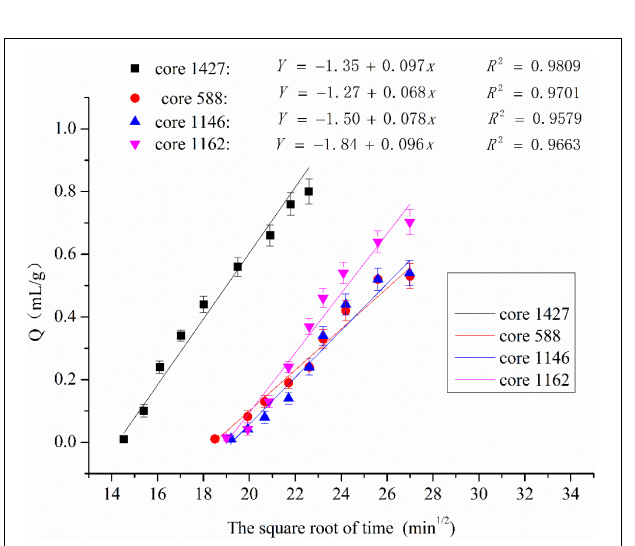
FIGURE 13 | Comparison between the loss of gas obtained by the two methods with the total gas